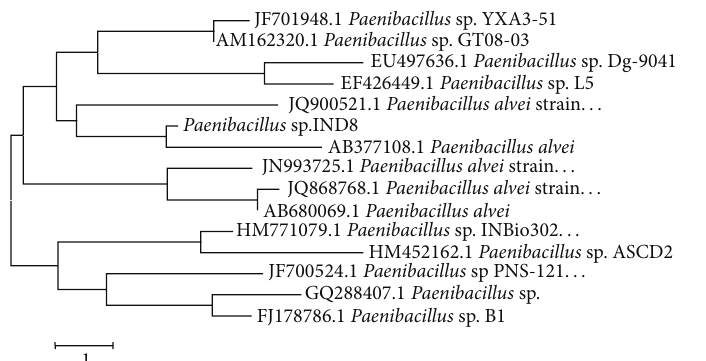
Figure 1: Phylogenetic relationships of stain IND8 and other closely related Paenibacillus based on 16S rDNA sequence. Bar = 1 substitution per